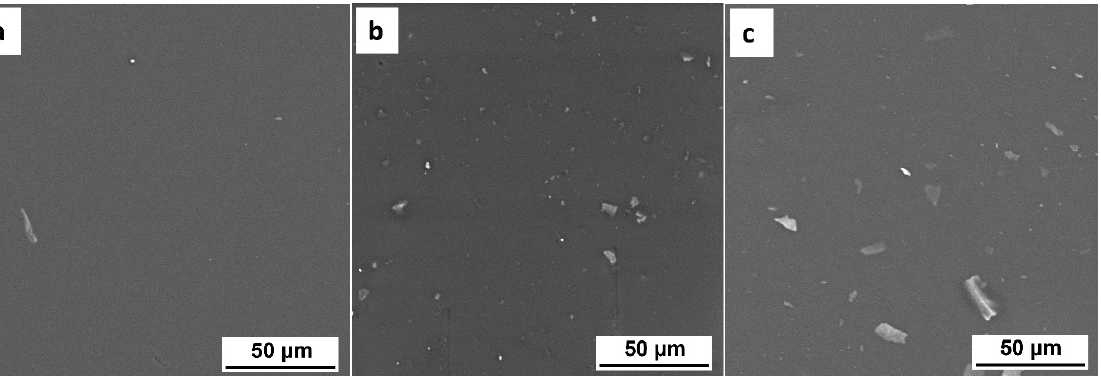
Figure 3. FESEM images of PLA/MXene composite films with ( a ) 0.3; ( b ) 1 and ( c ) 5 wt.% MXene.